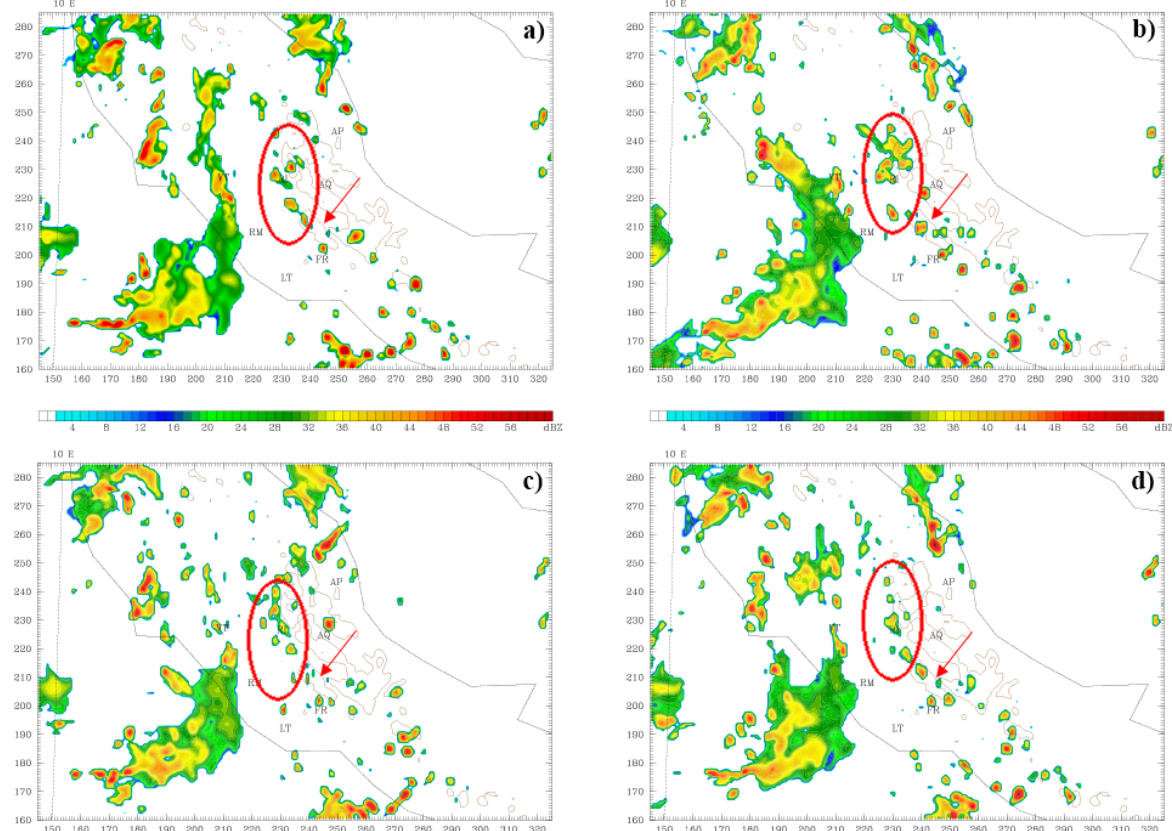
Figure 8. WRF reflectivity (dBZ) at 14:00UTC on 20 May 2008 for experiments (a) CTL, (b) CON, (c) RAD and (d) ALL.